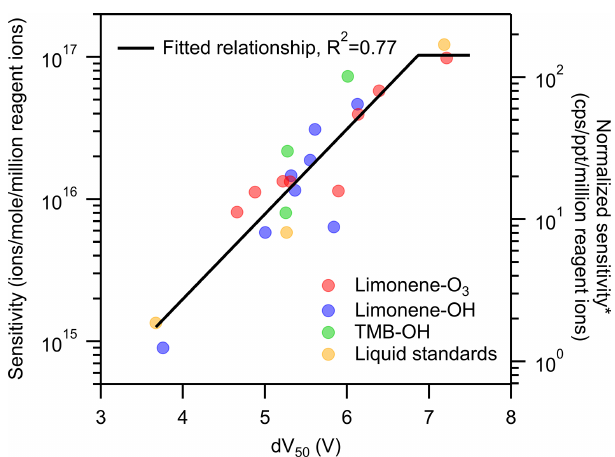
Figure 5. Sensitivity vs. d V 50 on a per-formula basis with a linear regression on the formulas. ∗ : unit converted for direct-air-sampling CIMS using 100mbar in IMR, a 2slpm sample flow rate, and a 2slpm reagent ion flow